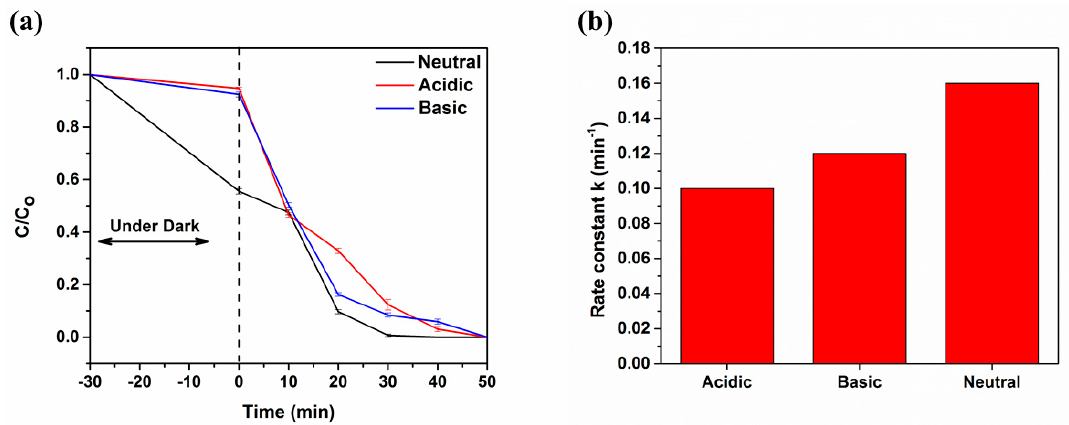
Figure 6. Effect of pH on MB dye decolorization for 2.5% AgFeO 2 /rGO/TiO 2 sample: ( a ) Relative concentration of MB dye decolorization with time and ( b ) rate constants calculated. Similarly, photocatalytic decolorization results of MB dye for 5% AgFeO 2 /rGO/TiO 2 in neutral,